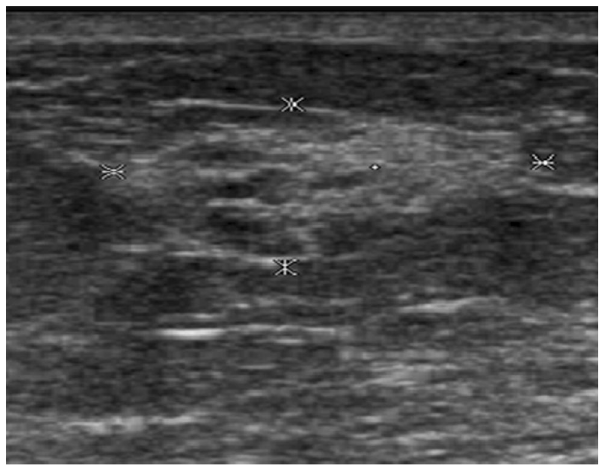
Fig. 13 Adenosis. Internal swelling of the right breast with a diameter of 15 mm in a 45-year-old woman, corresponding to a poorly demarcated mammographic opacity associated with punctate microcalcifications, evolving very slowly over a period of 4 years. Ultrasound: zone of mixed echogenicity, predominantly hyperechoic, with a long axis parallel to the skin, not modifying the ultrasound